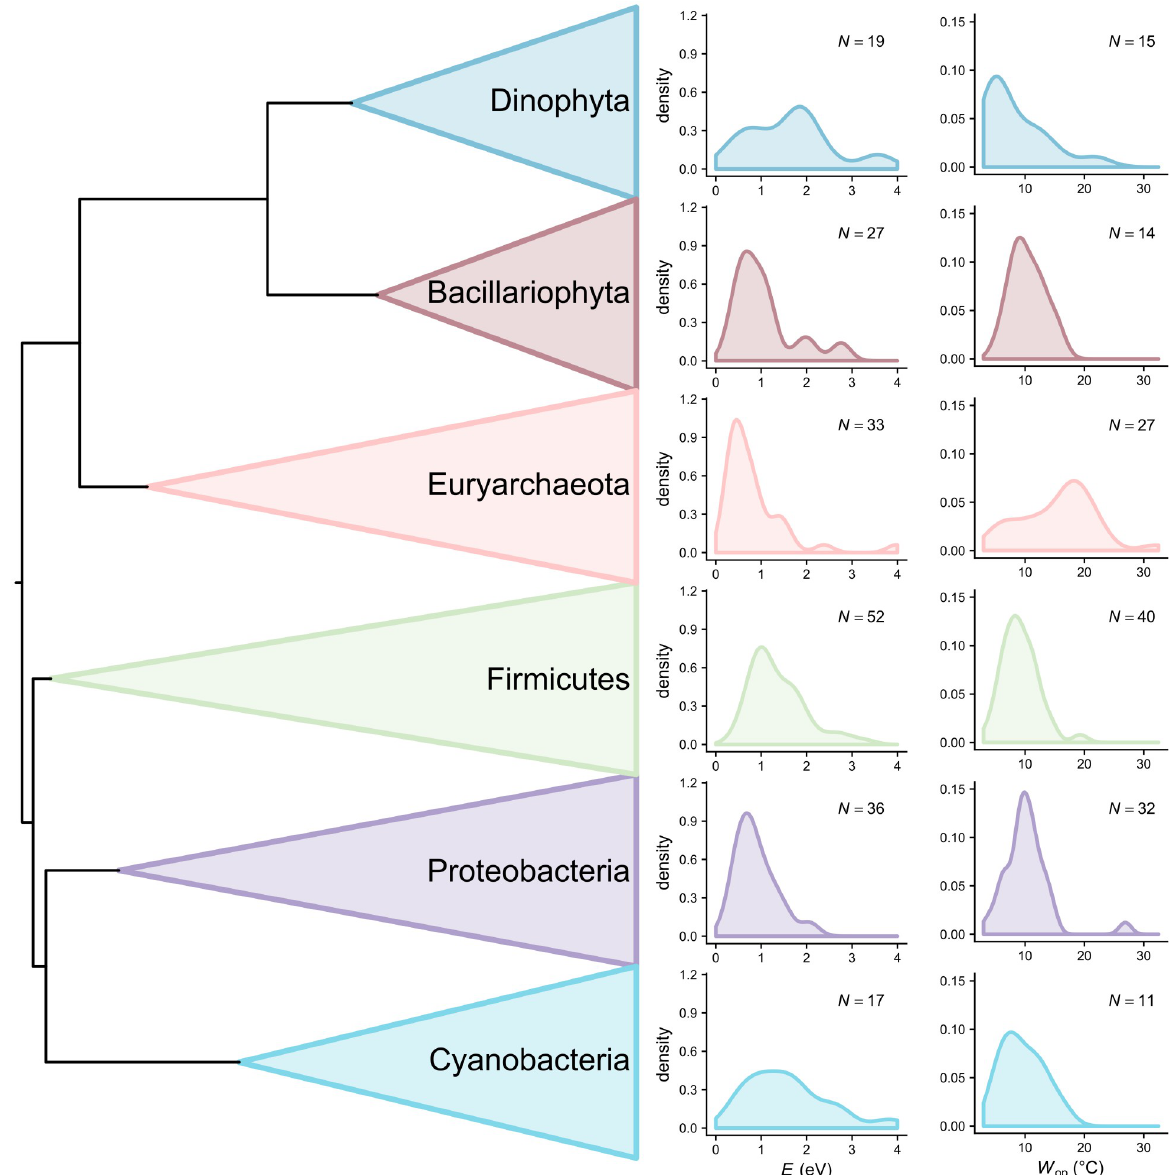
Fig 4. Distributions of thermal sensitivity estimates of r max for the largest (most species-rich) phyla of this study. In general, more variation can be observed within than among phyla. The data underlying this figure are available at